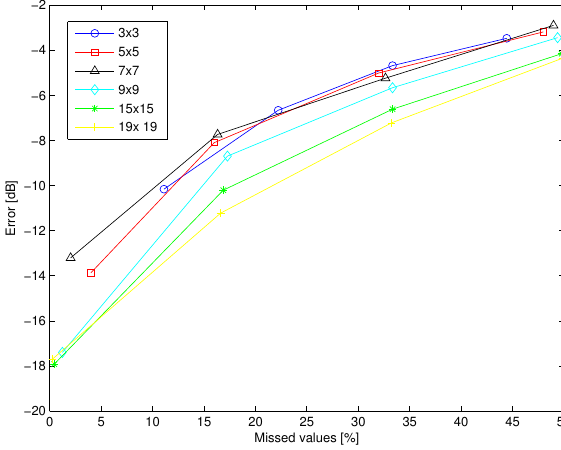
Figure 6. Error (dB) versus the percentage of missed data in the case of 3 × 3, 5 × 5, 7 × 7, 9 × 9, 15 × 15 and 19 × 19 MIMO system, 10 scatterers and SNR equal to − 20